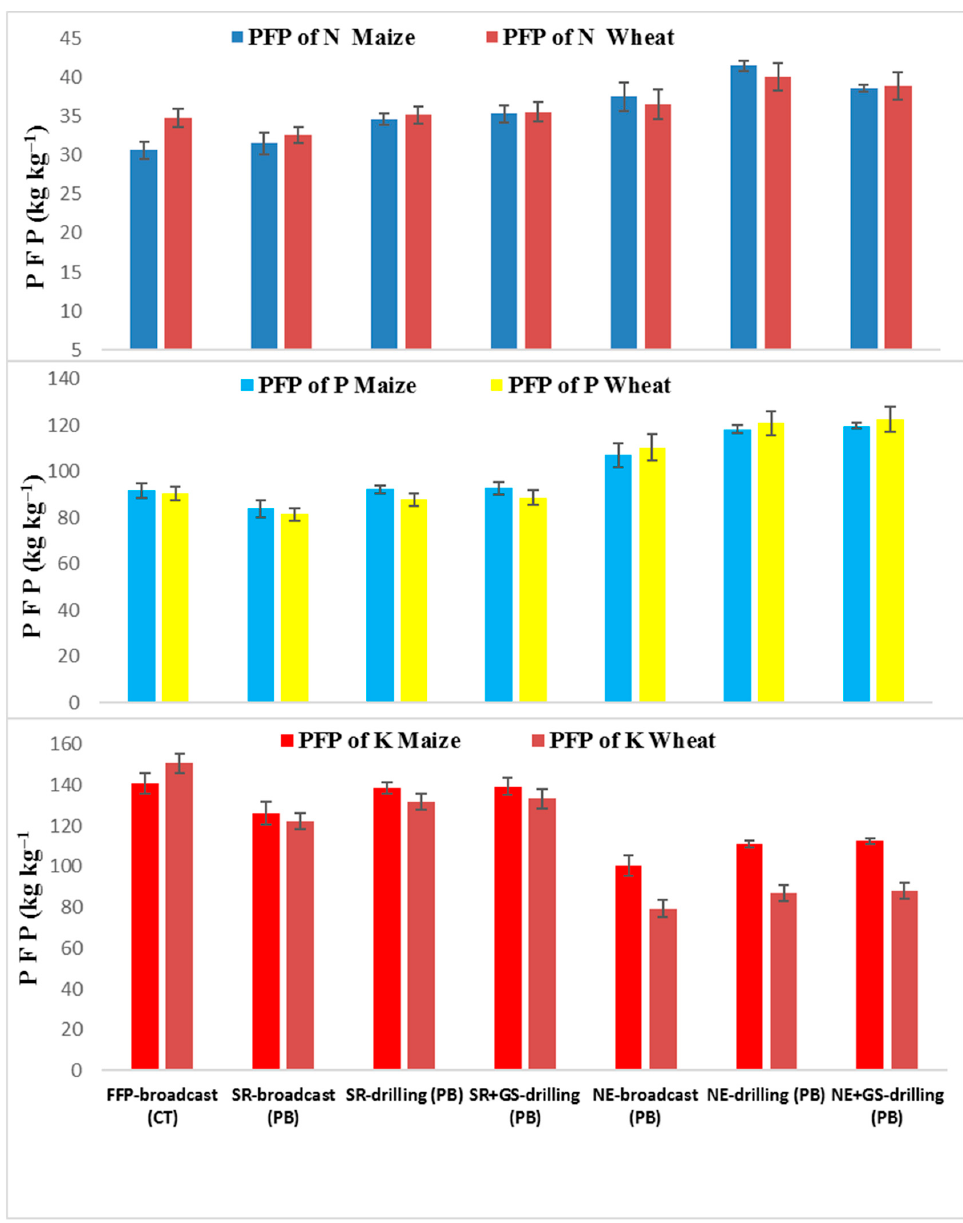
Figure 5. Partial factor productivity (PFP) of applied nitrogen, phosphorus and potassium as affected by different nutrient management strategies under maize-wheat system. Refer Table 2 for details of nutrient management treatments. Vertical bar shows standard error of the mean.